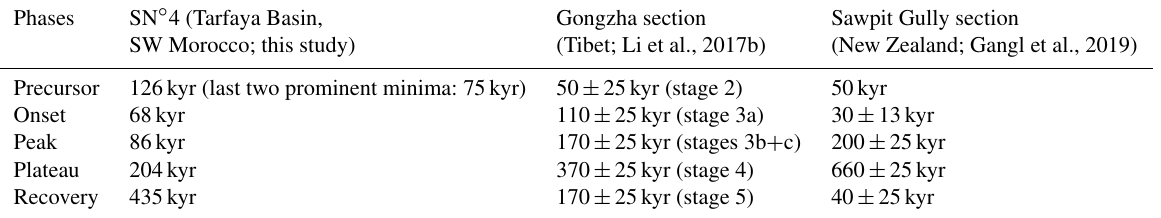
Total phosphorus (P total ) concentrations in Core SN ◦ 4 (Fig. 6) are overall below 5 mg g − 1 , except during two pe- riods of enrichment peaking at 220.19 m with 16.61 mg g − 1 and at 104.4 m with 7.53 mg g − 1 . Corresponding peaks in P total / Al give a weight ratio of 1.07 at 220.19 m and